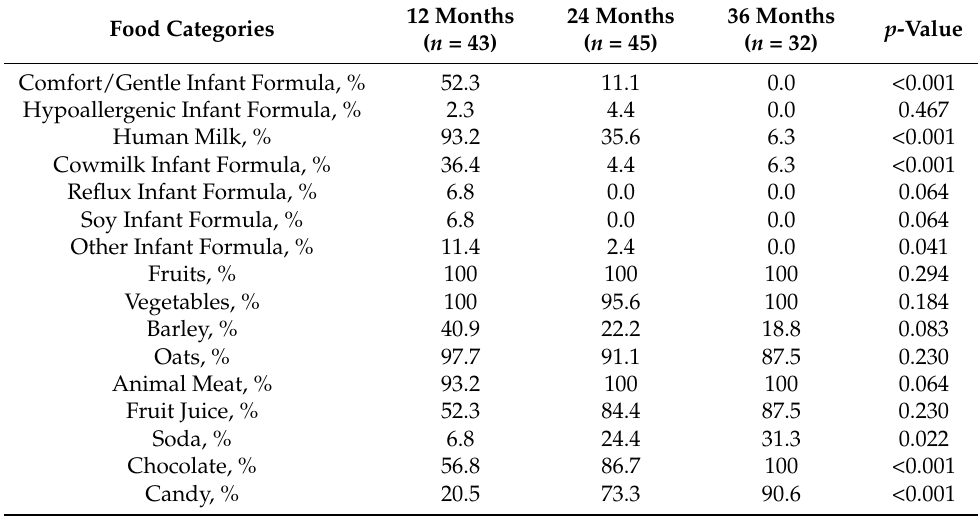
Table 5. Foods that children had consumed at least once in the past